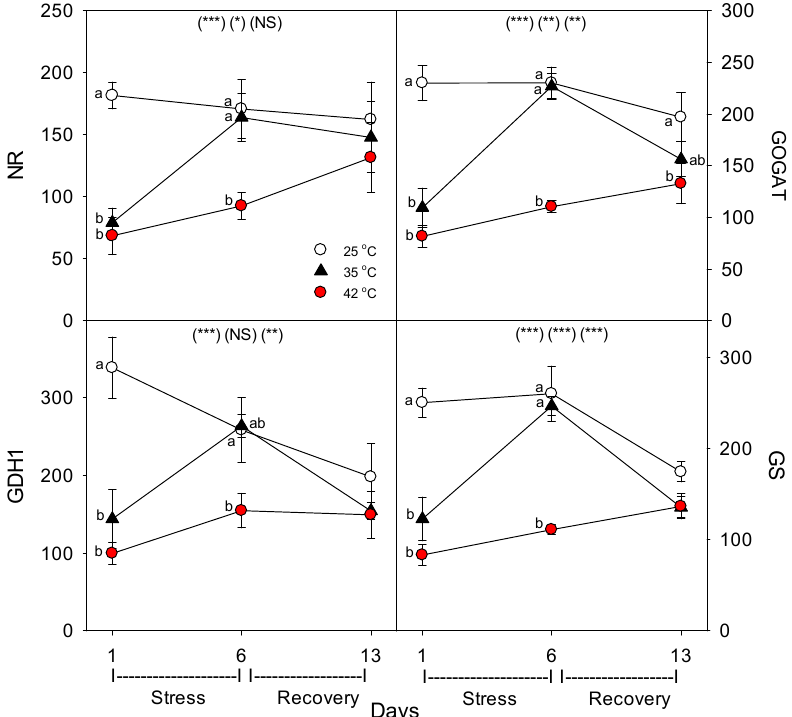
Figure 7. Effect of abrupt heat stress on relative levels of specific nutrient metabolism proteins (per g dry root) in roots of tomato: NR, nitrate reductase; GOGAT, glutamine oxoglutarate amino transferase; GDH1, glutamate dehydrogenase; GS, glutamine synthetase. Plants were grown at 25 °C/20 °C day/night (control), and then subsets of plants were heat stressed at 35 °C/30 °C or 42 °C/37 °C day/night for one or six days (maximum root temperatures = 32 °C or 39 °C), and then returned to control conditions for seven days of recovery (=day 13). Values are means ± 1 SE for four independent replicates from each harvest (days 1, 6, 13). Statistics are as in Figure 1. * p < 0.05, ** p < 0.01, *** p < 0.001.